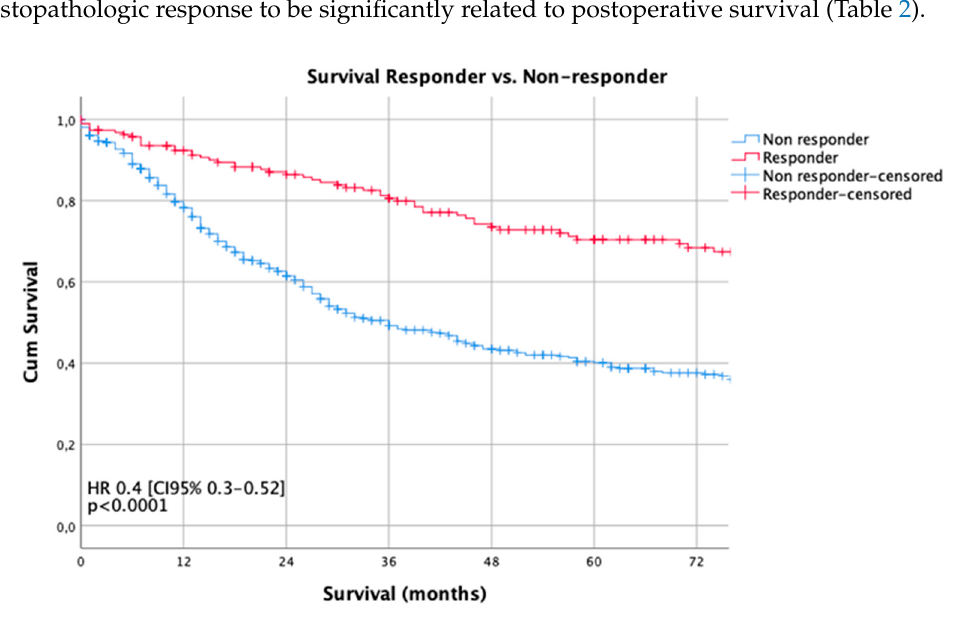
Figure 2. Survival curves according to the Becker grades. The Kaplan-Meier method and the log-rank test were used to compare the estimated survival by each Becker-stage. 2.2. Predictors of Overall Survival Univariate regression analysis revealed clinical stage, application of preoperative PLF, requirement of surgical extension, UICC-stage, grading, R-status, Lauren histotype (intestinal and